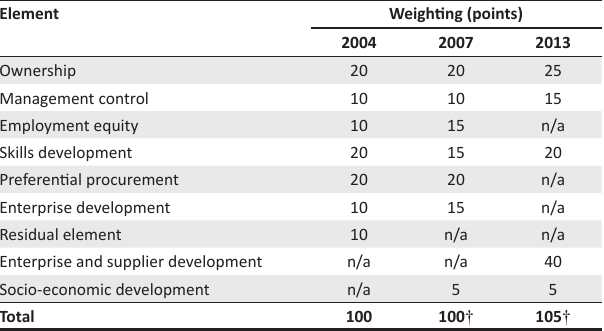
TABLE 1: Elements and weightings of the Broad-Based Black Economic Empowerment Codes.